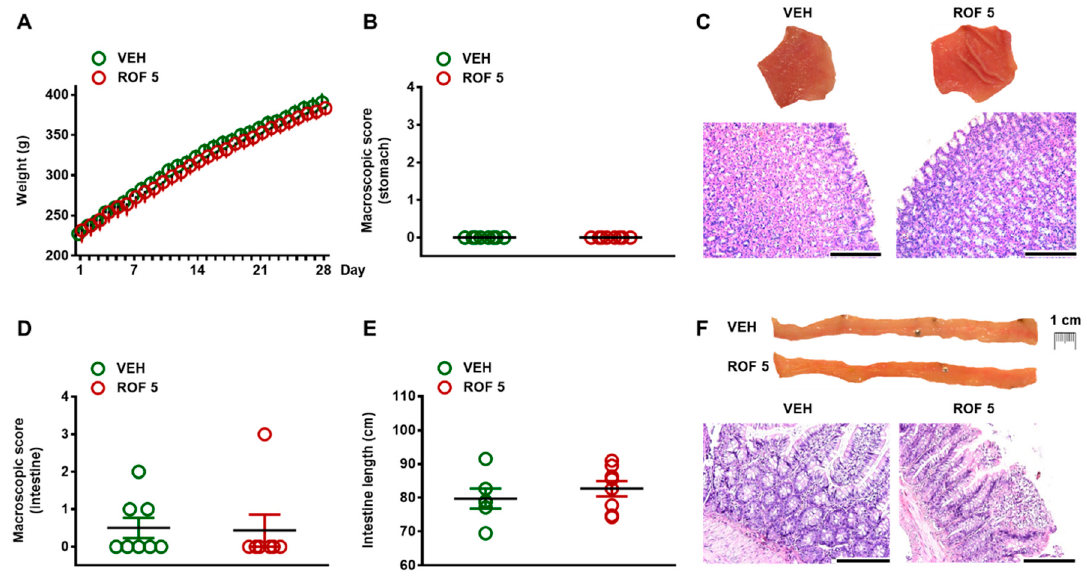
Figure 2. The effects of four-week vehicle (VEH, 1% methylcellulose) and rofecoxib (ROF, 5 mg/kg) treatment on the body weight ( A ) and gastrointestinal mucosa. B : Macroscopic scores of gastric mucosa; C : Representative photos of the gastric mucosa and histological micrographs (haematoxylin-eosin staining); D : Macroscopic scores of small intestinal mucosa; E : Length of small intestines; F : Representative photos of the jejunal mucosa and histological micrographs (haematoxylin-eosin staining), scale bar: 200 µM. There are no signs of any macroscopic or histological tissue damage. A : Results are expressed as the mean ± SEM. Panels B , D , and E : Circles represent the data of each rat, bars indicate the mean ± SEM. For statistical analysis two-way repeated measures ANOVA followed by Holm-Sidak post hoc test ( A ), Mann-Whitney U test ( B , D ), and Student’s t test ( E ) were used, n = 8/group.